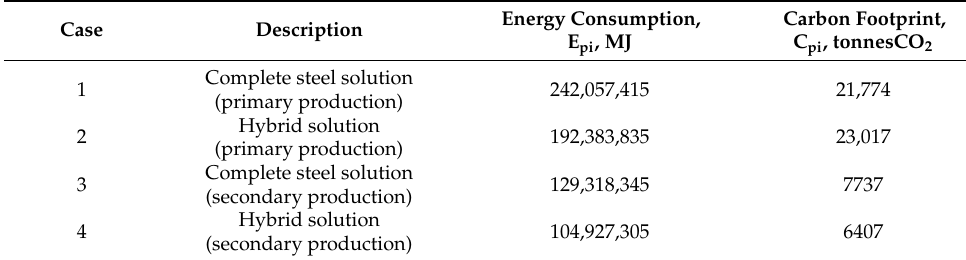
Table 5. Comparison of different solutions for ship